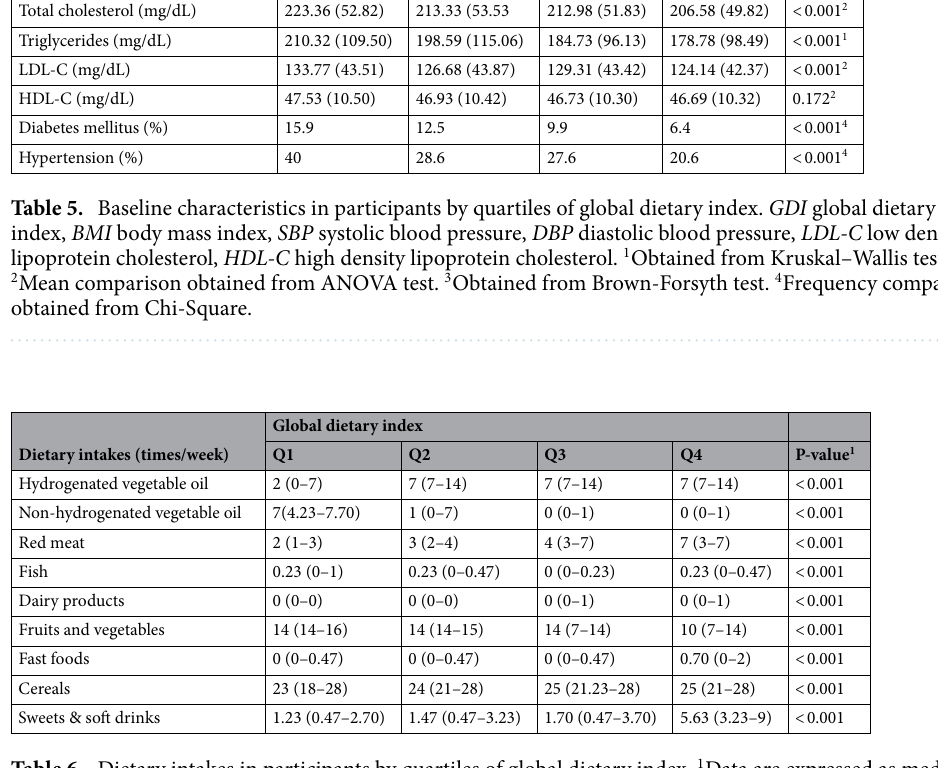
Table 6. Dietary intakes in participants by quartiles of global dietary index. 1 Data are expressed as median (Q1–Q3) due to non-normality. Comparison was obtained from Jonckheere-Terpstra test.